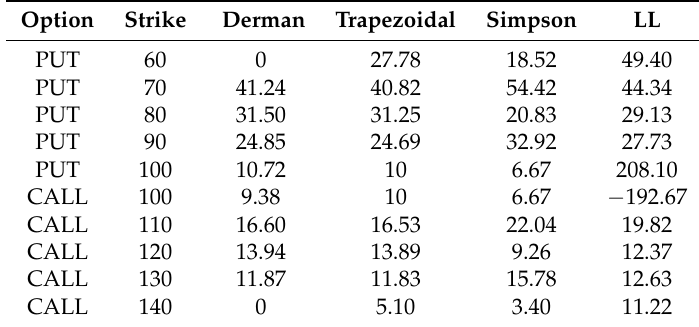
Table 1. Variance swap replication weights. LL stands for the optimal quadratic hedging solution of Leung and Lorig.